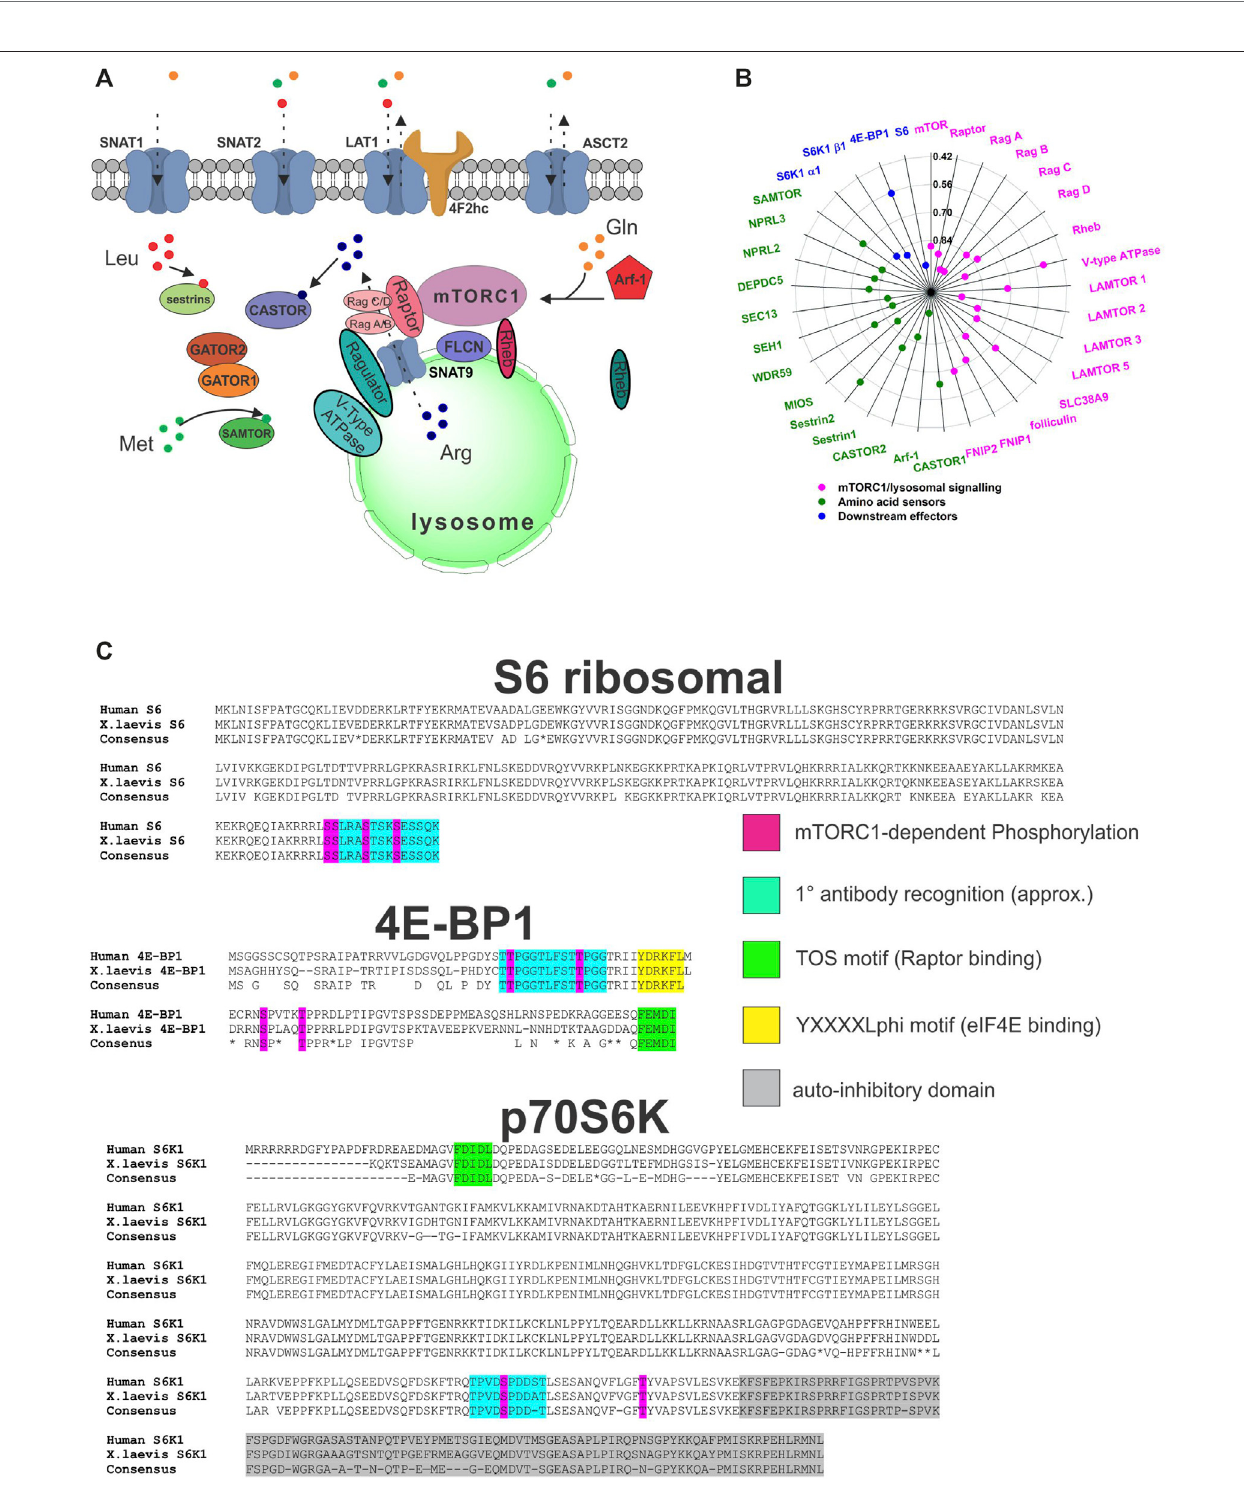
FIGURE 7 | The mTORC1 pathway and amino acid signaling in Xenopus laevis. (A) Overview of mTORC1 pathway components and associated amino acid sensorsandtransporters. (B) Sequenceconservationof X.laevis homologuesofmTORC1pathwaycomponents.Meanconservationisindicatedbyaredline.mTORC1 pathway components are divided into 3 groups: the central complex and lysosomal signaling (pink), the upstream amino acid sensing components (green), and the downstream effectors S6K1 (2 isoforms), 4E-BP1, and S6 ribosomal protein (blue). (C) Conservation of X. laevis mTORC1 effector antibody and phosphorylation sites. Depicted are the peptide sequences of human and X. laevis ribosomal protein S6, 4E-BP1, and p70S6K. Areas are indicated for sequences required for anti- humanantibodybinding – bothinnon-activatedandphosphorylated forms.Conservationis100%inregionsessentialfordownstreammTORC1functionsashighlighted by the fi gure legend. The sequence alignment was created by the Clustal Omega algorithm within the HMMER program suite. Sequence accession numbers can be found in Supplementary Table S6 .